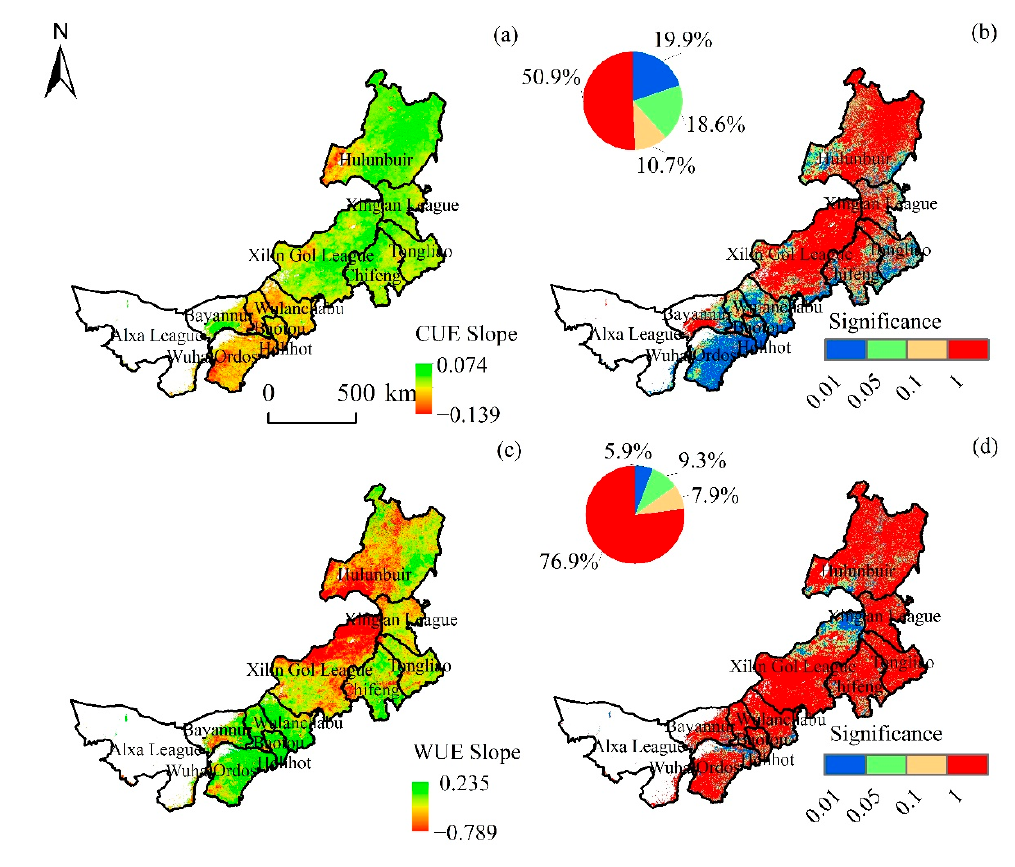
Figure 6. Spatial distribution of the rates of change in CUE and WUE and their significance in Inner Mongolia from 2001 to 2020. ( a , b ) Rate of change in CUE and its significance. ( c , d ) Rate of change in WUE and its significance.